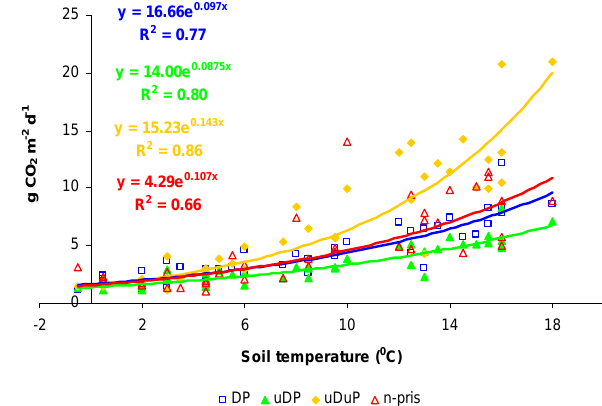
Fig. 5. The exponential relationship between CO 2 effluxes (mean Figure 5. The exponential relationship between CO 2 effluxes (mean of blocks) and of blocks) and soil temperature measured at 15cm depth from the different treatments at Flanders Moss between February 2008 and soil temperature measured at 15 cm depth from the different treatments at Flanders December 2009. Moss between February 2008 and December 2009.